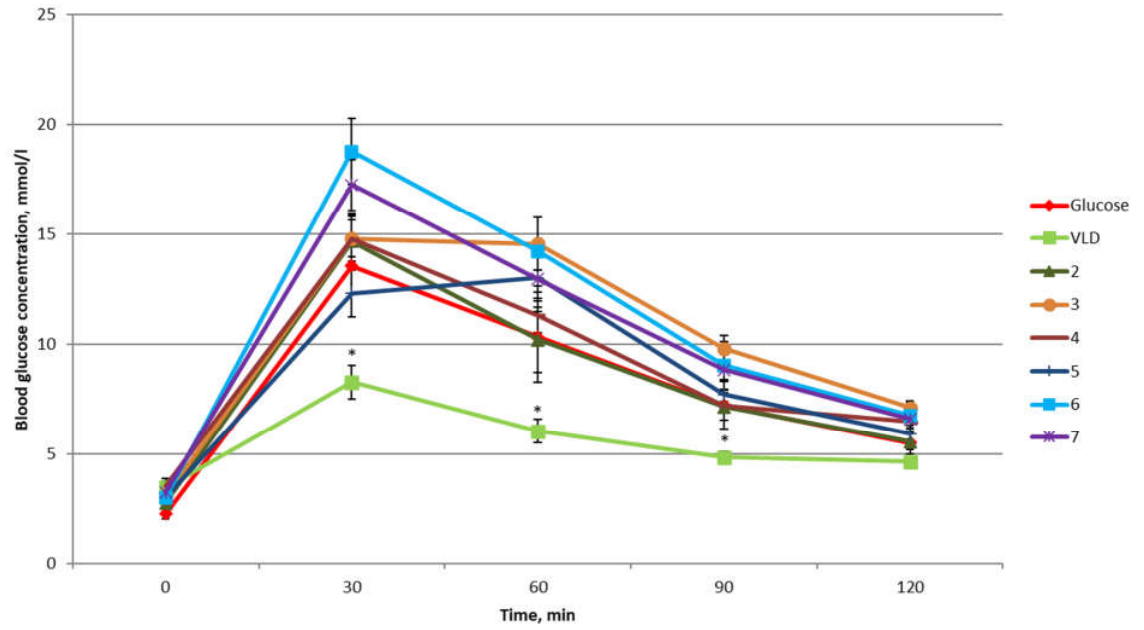
Figure 2. Results of the OGTT. * p < 0.05 compared to the «Glucose» group. VLD—vildagliptin.